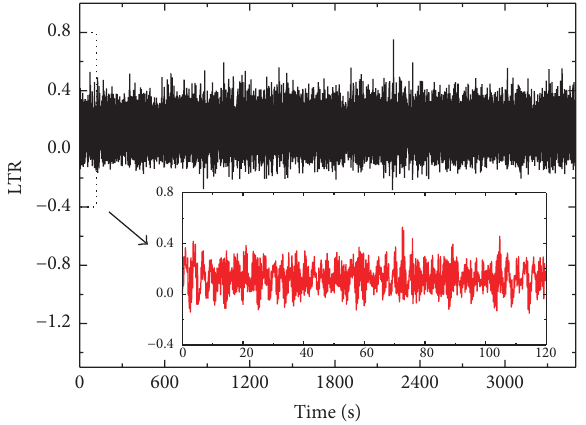
Figure 4: Time history of